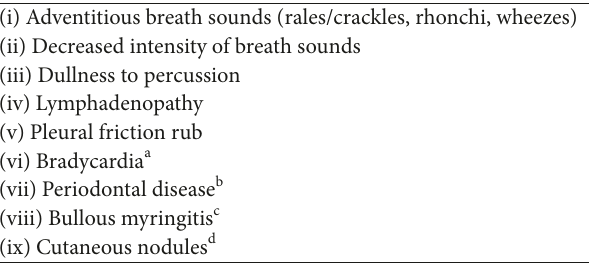
Table 1: Physical examination findings in CAP [7]. Table 2: Differential diagnosis in